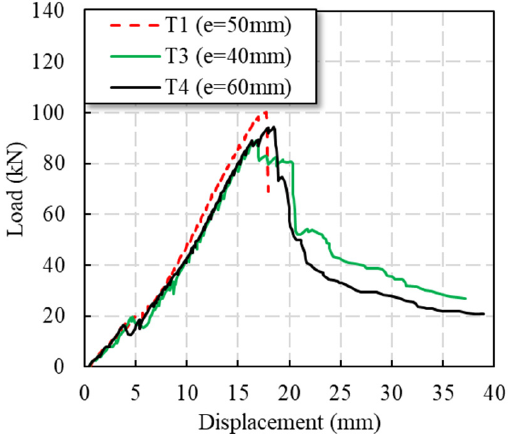
Figure 8. Load–displacement curves of specimens with different end distances .